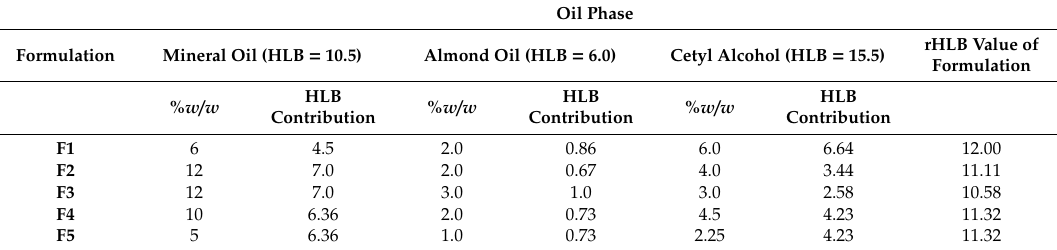
Figure1. Appearanceandvarioustypesofinstabilityobservedindi ff erentformulations. ( F1 )congealing Figure 1. Appearance and various types of instability observed in different formulations. (F1) and creaming were observed, ( F2 ) formation of lumps and phase separation were observed, ( F3 ) oil separation was observed, ( F4 ) stable moisturizing cream, and ( F5 ) stable moisturizing lotion. congealing and creaming were observed, (F2) formation of lumps and phase separation were observed, (F3) oil separation was observed, (F4) stable moisturizing cream, and (F5) stable Table 2. HLB contribution by the oil phase of di ff erent formulations to determine the rHLB of moisturizing lotion. the